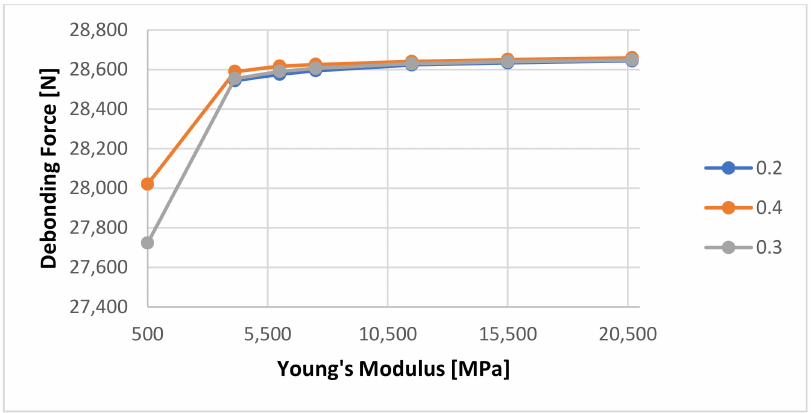
Figure 18. Detailed view of the calculated debonding force as a function of Young’s Modulus of the cement with a 7-day curing